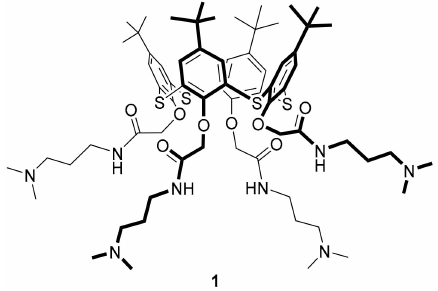
Figure 1. Core of multithiacalix[4]arene 1